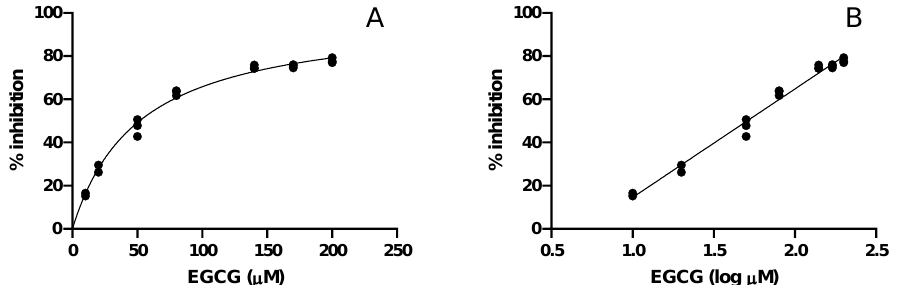
Figure 3. Percentage of inhibition as a function of EGCG concentration ( A ) and log EGCG concentration ( B ) in the Fe(II)/phosphate buffer system. tion ( B ) in the Fe(II)/phosphate buffer